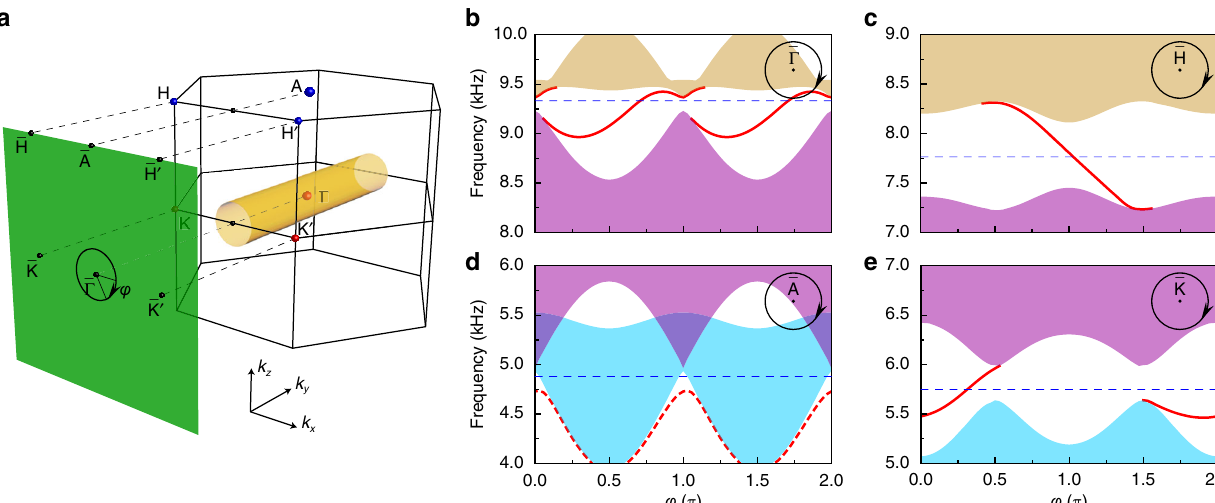
Fig. 3 Numerical evidence for the topological charges of QWPs through nontrivial surface states. a Bulk BZ and its surface projection to the k x – k z plane. The black circle (of radius 0 : 2 π = a ) is the projection of the orange tube surrounding the QWP at Γ . b Projected band structure along the circular path in a . The color shadows are the projections of different bulk bands, the red solid lines indicate the presence of topological surface states, and the blue dashed line labels the frequency of the Weyl node at Γ . c – e Similar to b , but for the paths each encircling a different Weyl node from Fig. 1b. The red dashed line in d corresponds to topologically trivial surface